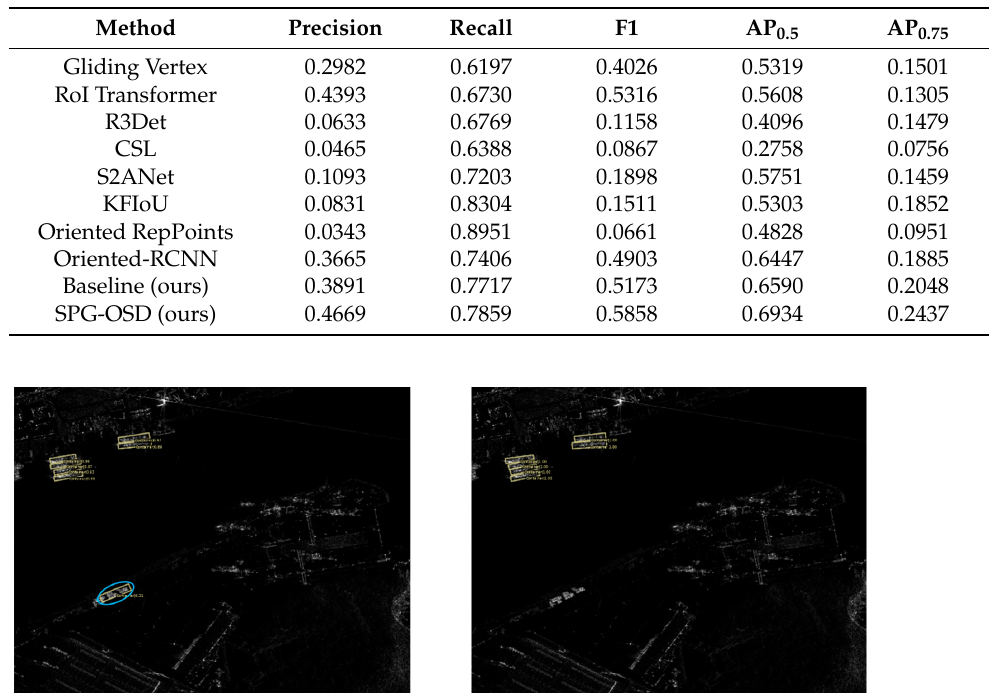
Table 2. Comparison with state-of-the-art methods.